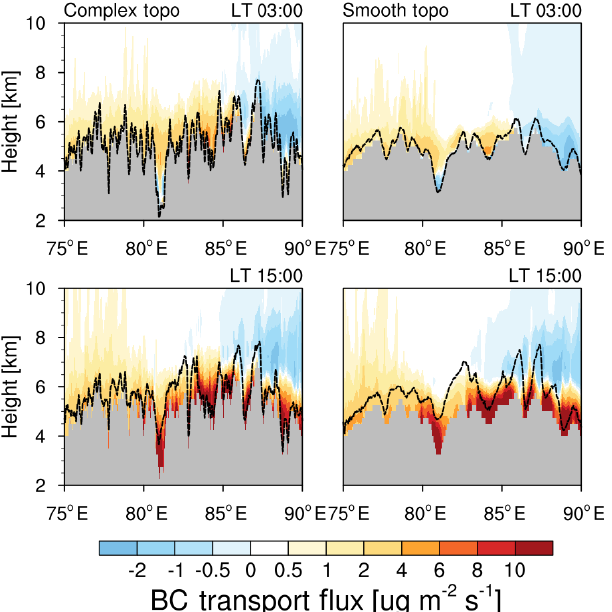
Figure 10. Latitude–height cross section of BC flux (vector) across the mountain (shown as the eastern black solid line in Fig. 3) from the simulations with the complex and smooth topographies at 03:00 and 15:00 local time (LT) averaged for 1–20 April 2016. Contour represents the BC concentration.